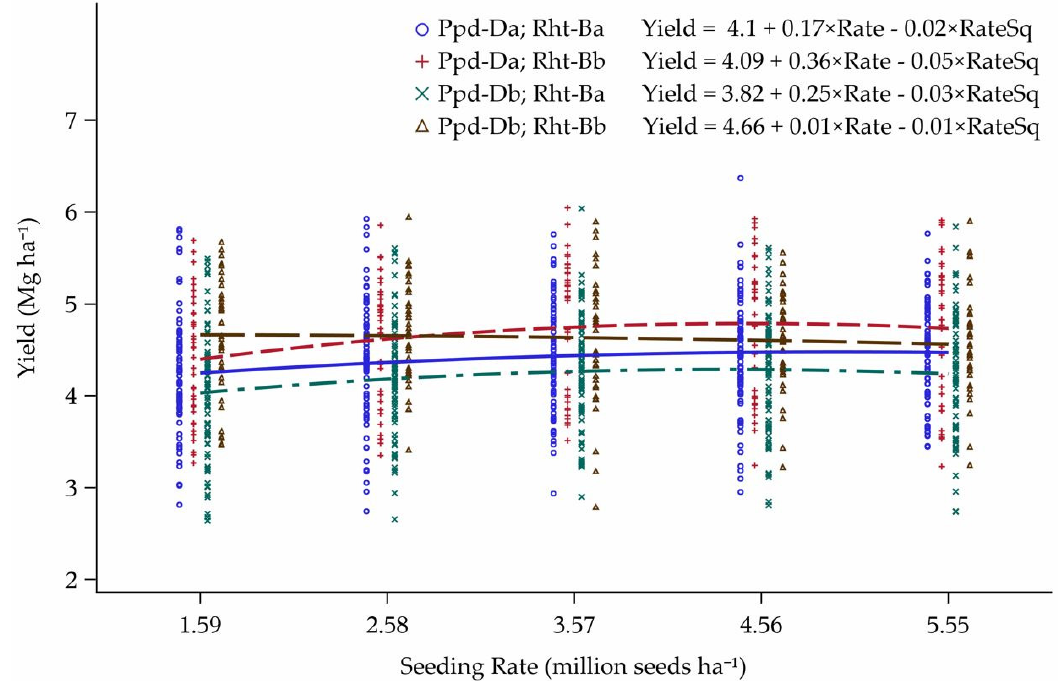
Figure 13. Yield response curves to seeding rate for the interaction between Rht-B and Ppd-D alleles over the six lowest-yielding environments in Minnesota and North Dakota, 2013–2015. Seeding rate for the peak of the curve: Ppd-Da ; Rht-Ba = 4.16, Ppd-Da ; Rht-Bb = 4.26, Ppd-Db ; Rht-Ba = 3.98, and Ppd-Db ; Rht-Bb = 0.62 million seeds ha − 1 .